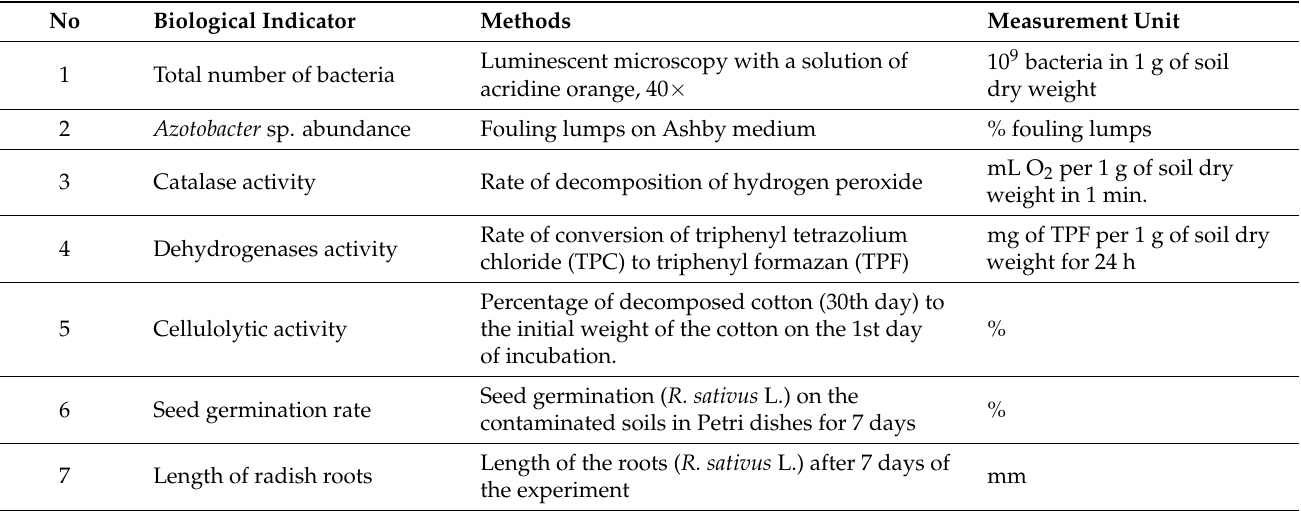
Table 2. Methods for the measurement of biological